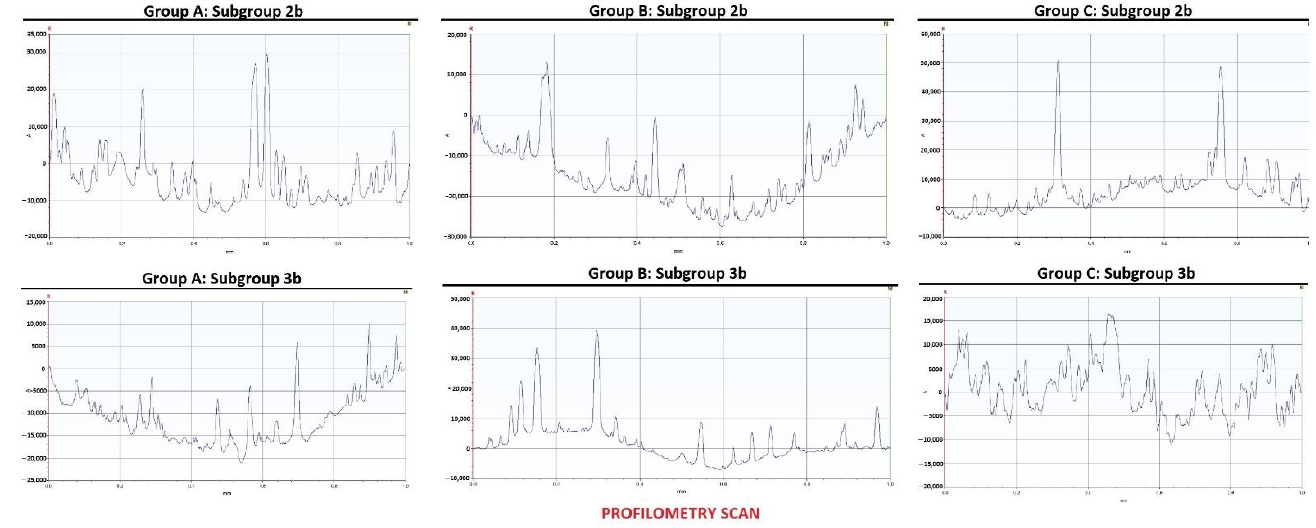
Figure 2. Profilometric measurements for two samples from groups A, B, and C in subgroups 2b and 3b. Table 2. Mean Ra value and standard deviation for groups A, B, and C in each study subgroup and statistical differences between groups A, B, and C in each study subgroup.